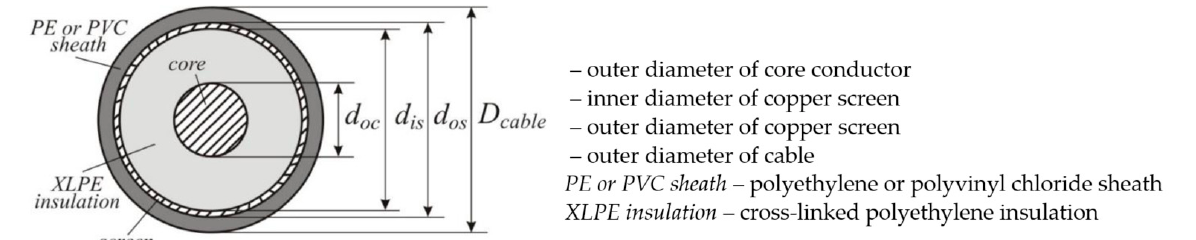
Figure A3. Simplified image of the XLPE-cable layers structure.